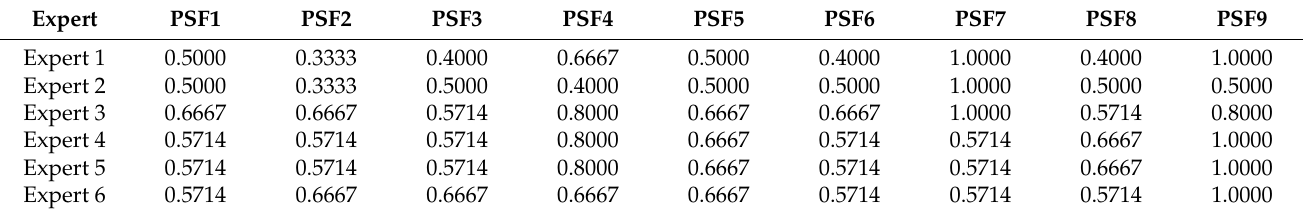
Table 9. The grey relation coefficient of each PSF’s likelihood in ST 1.1 concerning each expert’s evaluation.